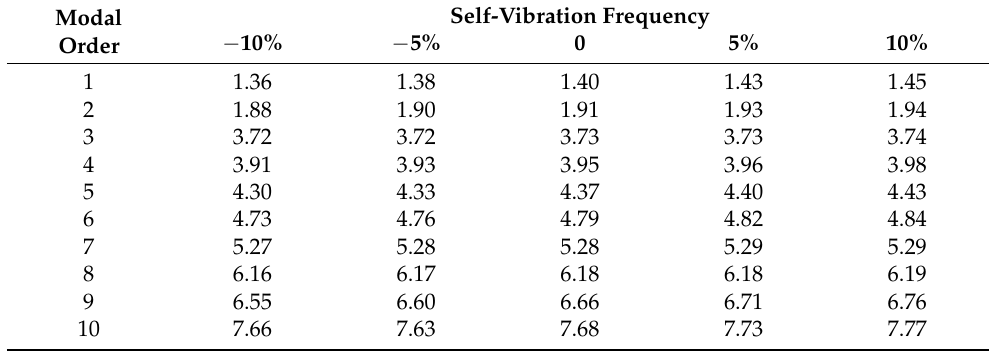
Table 7. Self-vibration frequencies (Hz) for different V-shaped pier stiffnesses of the original structure. Modal